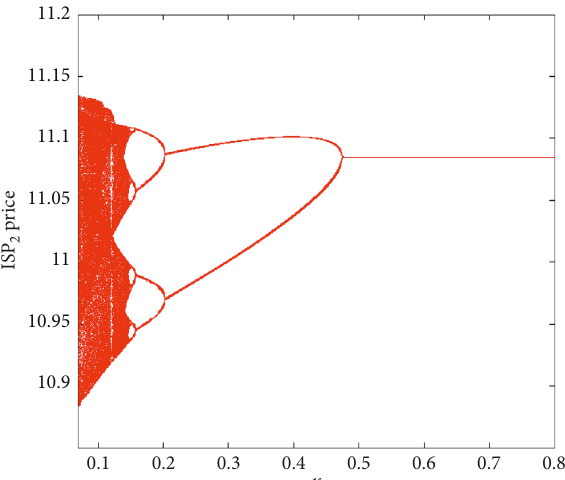
Figure 6: Bifurcation diagrams of p